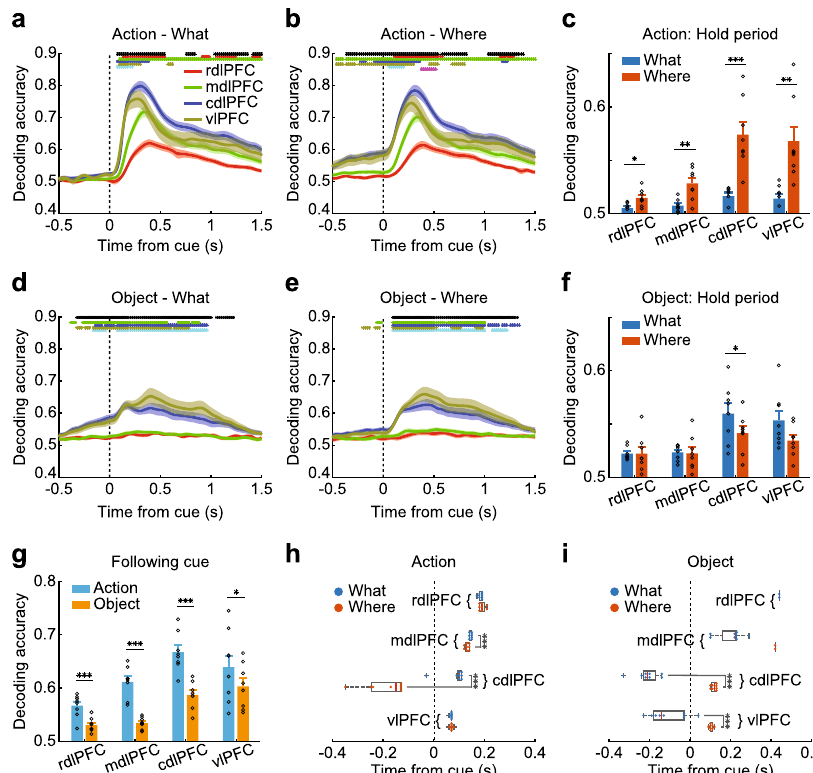
Fig. 3 Decoding of chosen action and object. a , b , d , e The time course of decoding accuracy in each region that encoded action in What ( a ) or Where blocks ( b ), or encoded object in What ( d ) or Where ( e ) blocks. c , f The average hold period decoding accuracy in each region, when decoding action ( c ) or object information ( f ). Hold period: − 0.5 to 0 s from cue onset. g The decoding accuracy in each region split by domain type, averaged from 0 to 1.5 s from cue onset. h , i The response latency of decoding accuracy in each region for encoding action ( h ) and object ( i ), split by block type. The solid circles represent the response latency of each session. Boxplot box indicates the fi rst and third quartile, the centerline of the box indicates the median, and whisker lengths re fl ect the interquartile range multiplied by 1.5. Shaded zones and error bars represent mean ± SEM, n = 8 for each line, bar, or box. A two-sided t test was used to compare two populations, * p < 0.05, ** p < 0.01, *** p < 0.001. The black * symbols at the top of each panel indicate a signi fi cant difference among the four regions (1-way ANOVA, p < 0.01). The red, green, blue, yellow, cyan, and magenta * symbols indicate a signi fi cant difference (two ‐ sided paired t test, p < 0.01) between the rdlPFC and mdlPFC, rdlPFC and dlPFC, rdlPFC and vlPFC, mdlPFC and cdlPFC, mdlPFC and vlPFC, and cdlPFC and vlPFC. Source data are provided as a Source Data fi